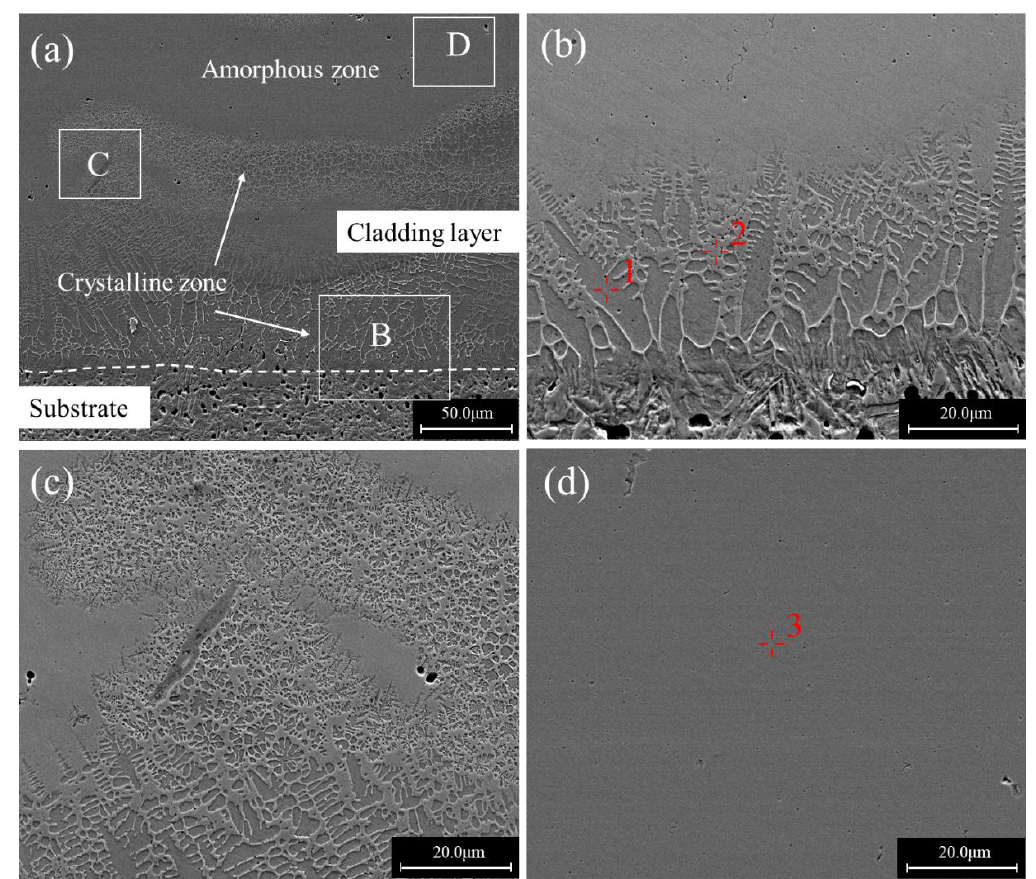
Figure 3. Cross sectional morphologies of a single-bead cladded specimen produced at the scanning speed of 6 mm/s: ( a ) Overall view; ( b ) an enlarged view of region B in ( a ); ( c ) an enlarged view of region C in ( a ); ( d ) an enlarged view of region D in ( a ).